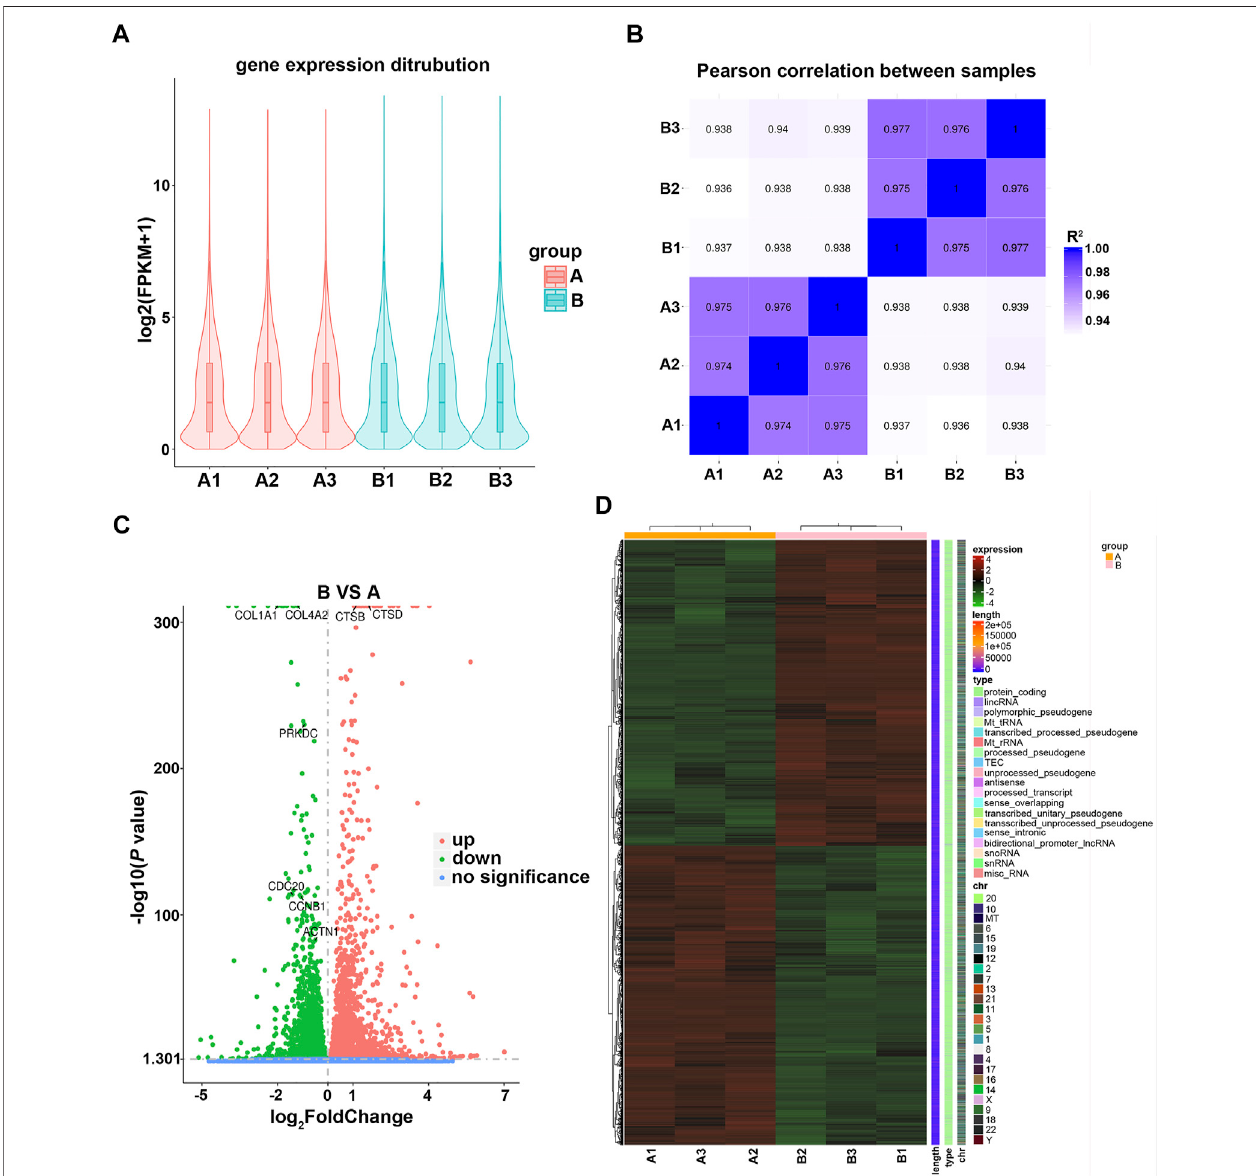
FIGURE 4 | (A) Violin plot of the gene expression distribution between control and 1 mg/ml fucoidan exposed group. A1, A2, A3 indicate 0 mg/ml fucoidan exposed group; B1, B2, B3 indicate 1 mg/ml fucoidan exposed group. (B) The heat map of Pearson correlation between samples. (C) The volcano plots of DEGs. The red dots indicate upregulated genes, green dots indicate downregulated genes, and blue dots indicate non-differentially expressed genes. (D) The heat map of DEGs between the 0 mg/ml fucoidan exposed group and 1 mg/ml fucoidan exposed group.